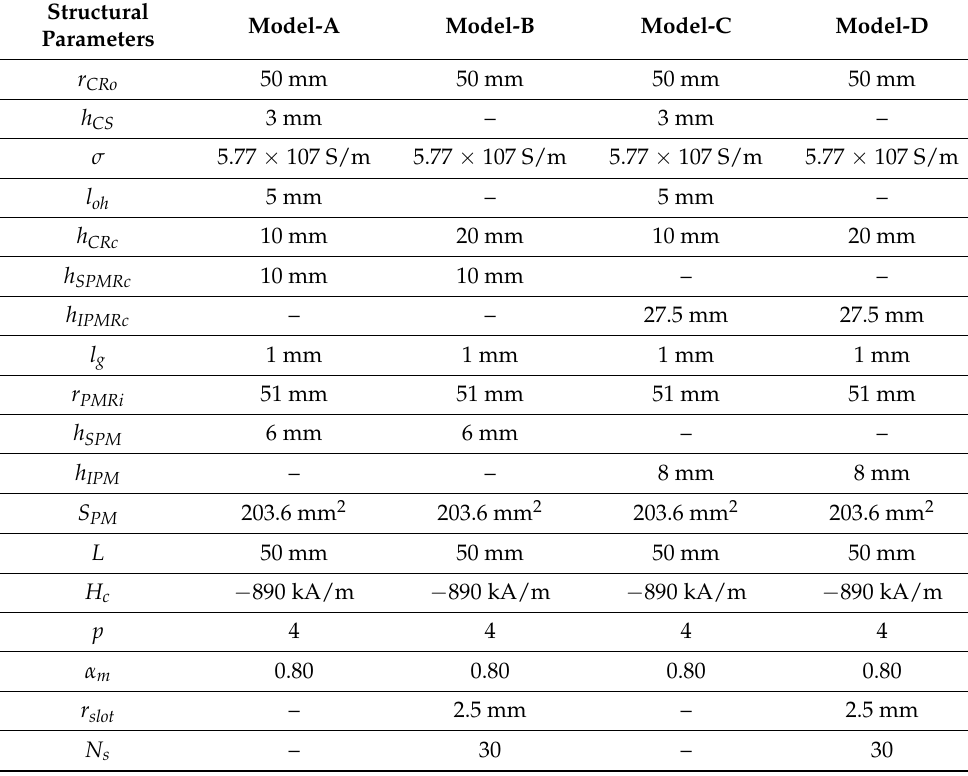
Table A1. The main design parameters of the four typical